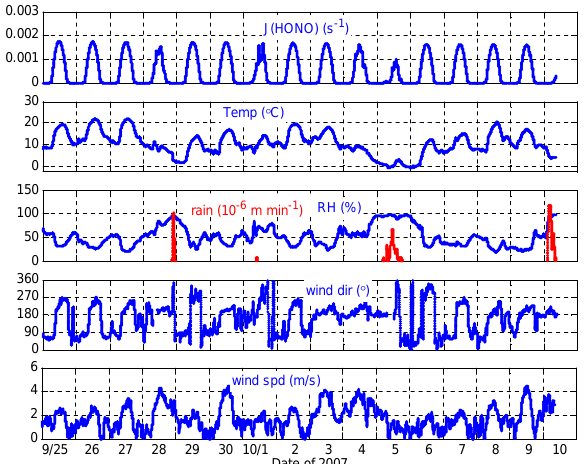
Fig. 3. Time series of HONO photolysis frequency, temperature, relative humidity, rain fall, wind direction, and wind speed between 25 September and 10 October 2007 during BEARPEX2007 when the wet chemistry HONO measurements were available. J (HONO) was calculated based on the TUV model and measured solar radia- tion (see Sect. 2.2.3 for